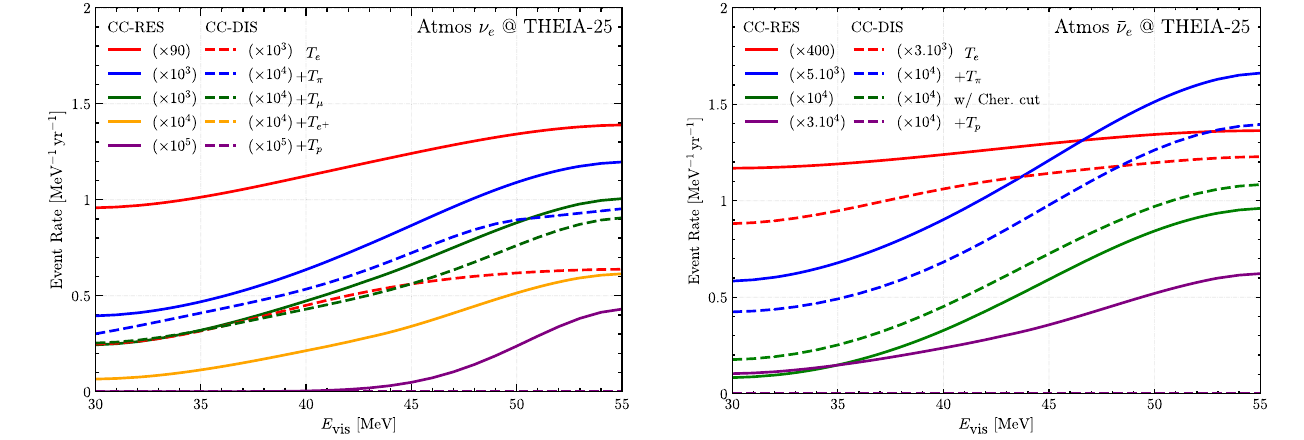
window [30, 55]MeV to higher energy. Similarly, the ¯ ν e spectrum has the same feature with the primary electron ( T e , red), charged π − ( + T π , blue) or with Cherenkov cut (w/ Cher. cut, green), and proton ( + T p , purple). Multiplication factors have been used to make the highly sup- pressed spectrum